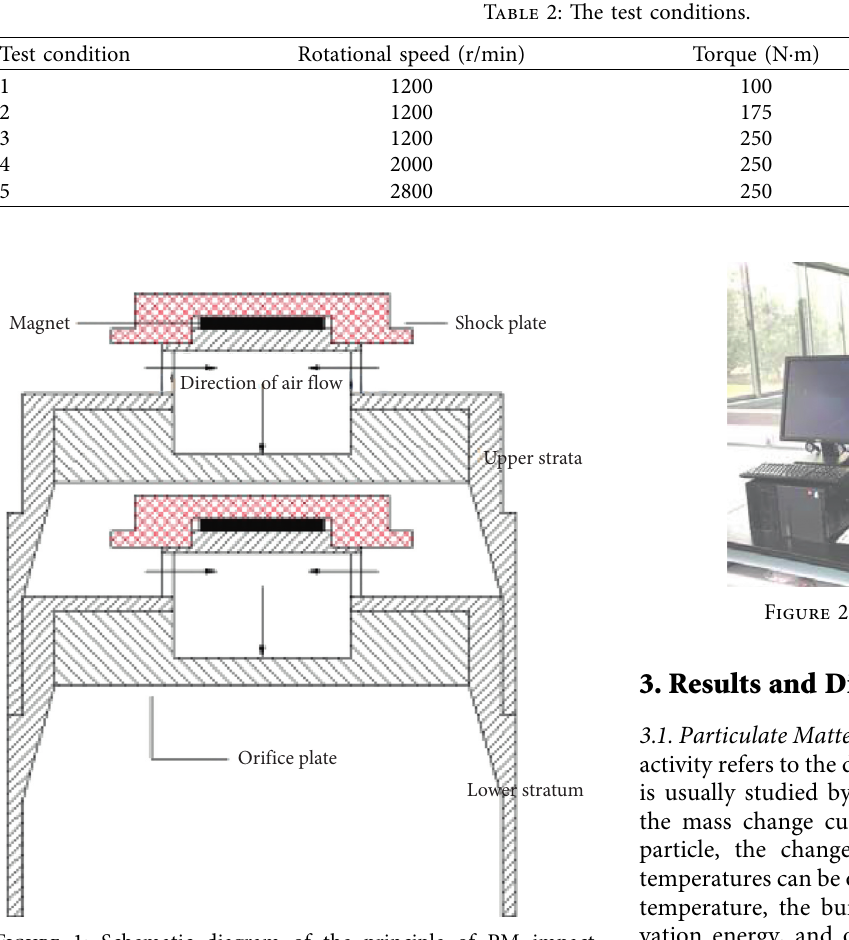
Figure 1: Schematic diagram of the principle of PM impact sampling.